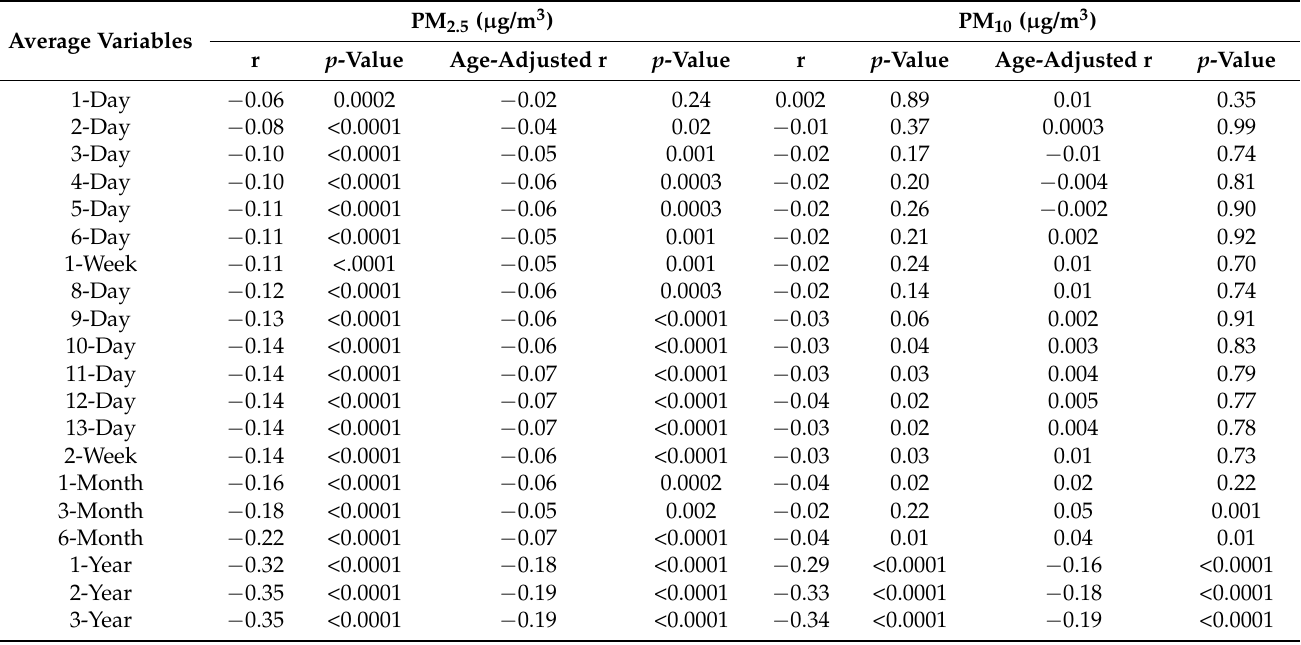
Table 3. Pearson correlations between PM 2.5 and PM 10 with cognitive score, with and without age adjustment (n =